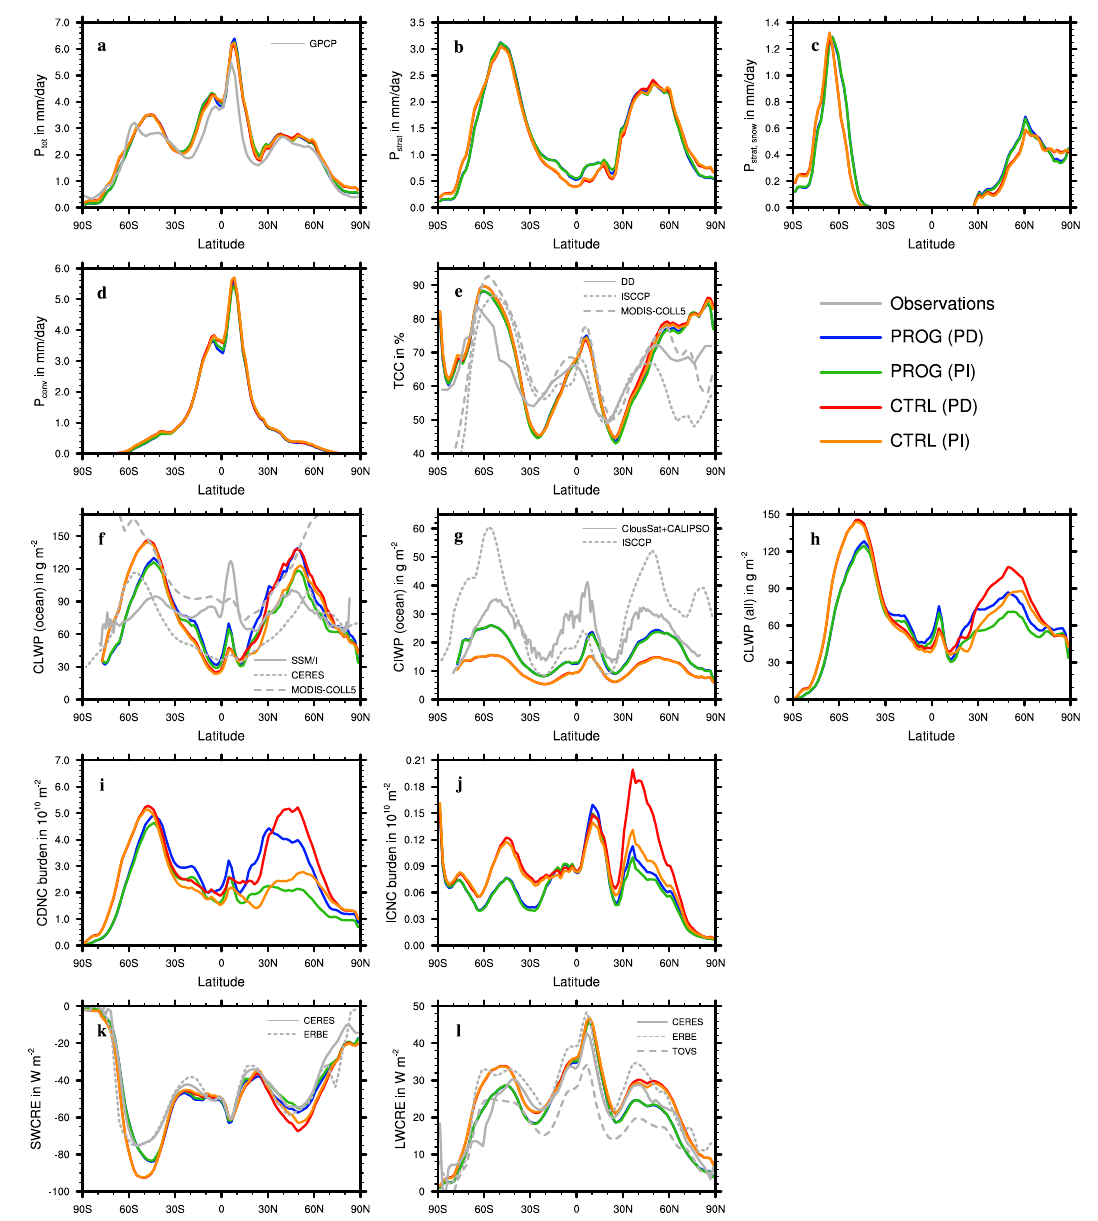
Figure 2. Zonal annual mean average of (a) total precipitation ( P tot ), (b) stratiform precipitation ( P strat ), (c) stratiform snow precipitation ( P strat, snow ), (d) convective precipitation ( P conv ), (e) total cloud cover (TCC), (f) cloud liquid water (CLWP) and (g) cloud ice water path (CIWP) over the ocean, (h) the CLWP over whole globe, (i) the CDNC and (j) ICNC burden, (k) shortwave (SWCRE) and (l) long-wave cloud radiative forcing (LWCRE) for PROG and CTRL (PD and PI) from 2000–2011. The following observations are used: GPCP, the Global Precipitation Climatology Project (Adler et al., 2003) in (a) ; DD, surface observations (Hahn et al., 1994) in (e) ; ISCCP, International Satellite Cloud Climatology Project (Han et al., 1998; Rossow and Schiffer, 1999) in (e, g) ; MODIS-COLL5, Moderate Resolution Imaging Spectro- radiometer, Collection 5 (http://modis-atmos.gsfc.nasa.gov/products.html) in (e, f) ; SSM/I, Special Sensor Microwave/Imager (Wentz, 1997) in (f) ; CERES, Clouds and Earth’s Radiant Energy System (Wielicki et al., 1996) in (f) , (k) and (l) ; CloudSat + CALIPSO, ensemble mean satellite observations of CloudSat and the Cloud-Aerosol Lidar and Infrared Pathfinder Satellite Observations (Li et al., 2012) in (g) ; ERBE, Earth Radiation Budget Experiment (http://science.larc.nasa.gov/erbe); and TOVS (TIROS Operational Vertical Sounder) (Scott et al.,